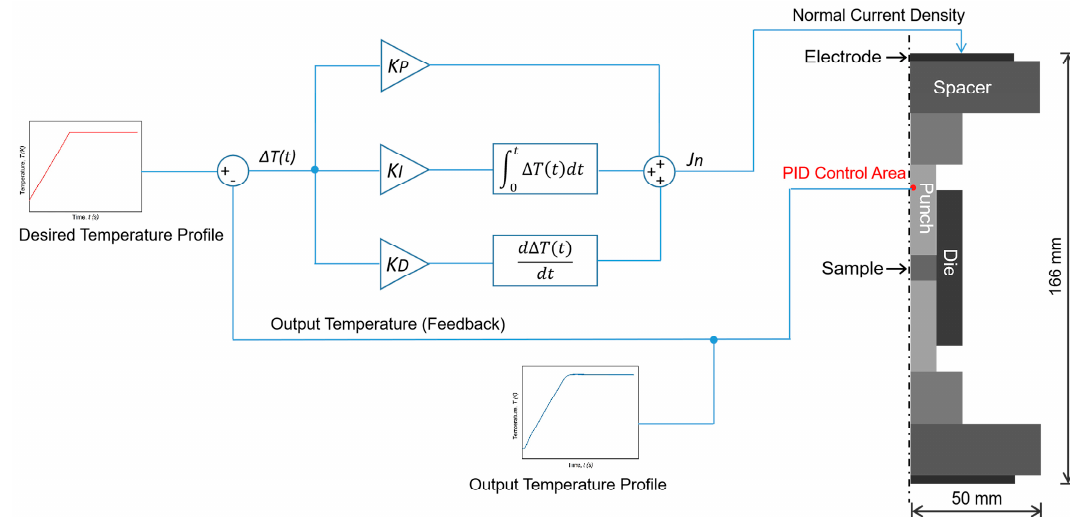
Figure 1. Schematic diagram of the SPS setup showing the component configuration and the control